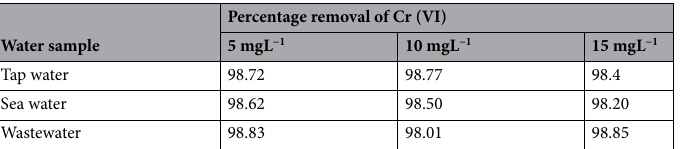
Table 4. Adsorptive removal of Cr(VI) by Fe 0.75 Cu 0.25 -BDC@Alg-MoO 3 /GO from real water samples at optimum conditions (Cr (VI) concentrations (5, 10 and 15 mgL −1 ) and 70 mg of adsorbent and pH 3).